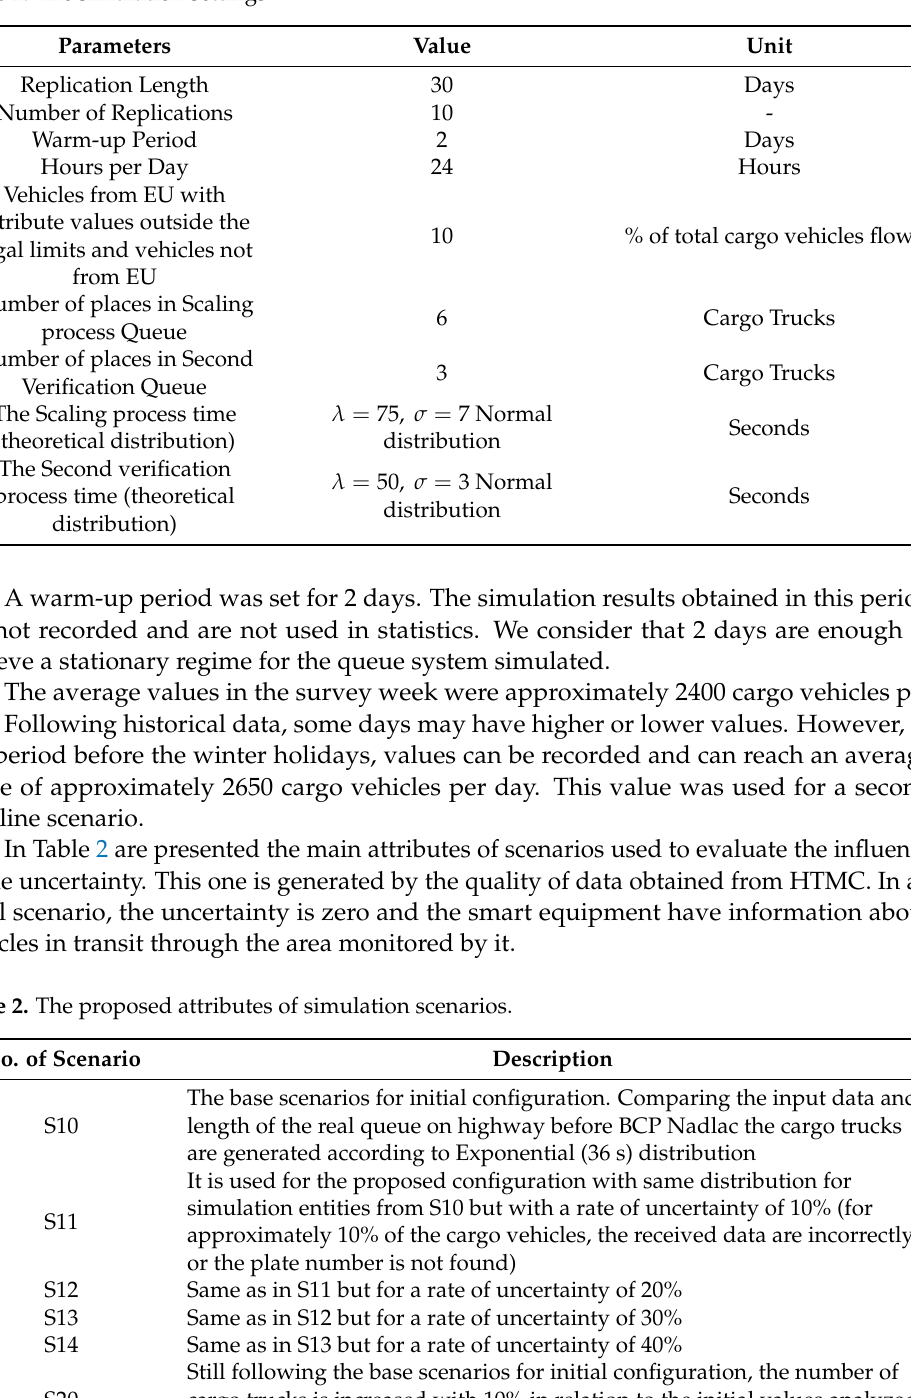
Table 1. The simulation settings.